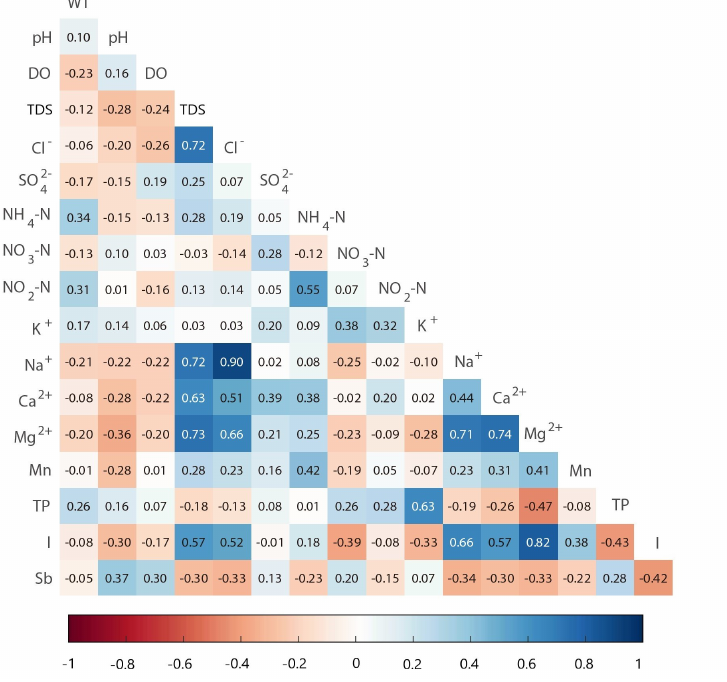
Figure 5. Correlation coefficients between groundwater quality